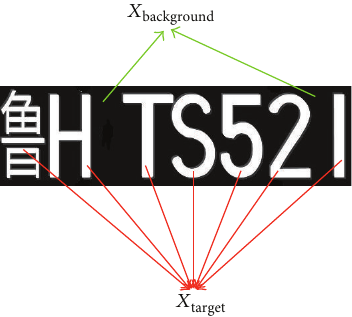
Figure 1: An example of the license plate